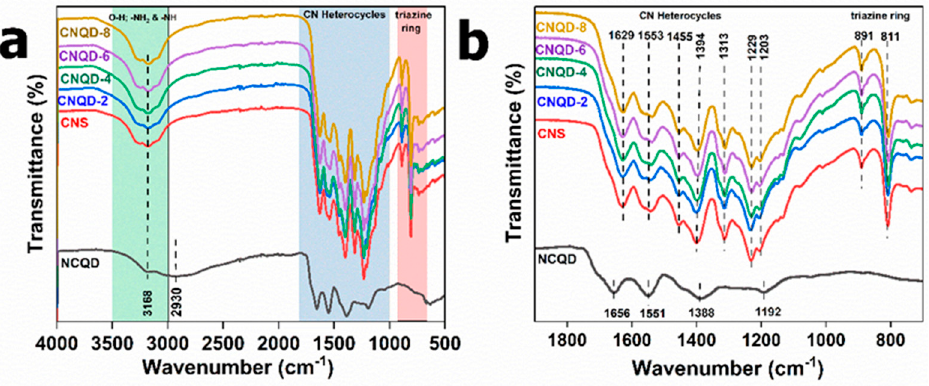
Figure 6. Full ( a ) and enlarged FTIR spectra ( b ) of NCQD, CNS, and CNQD photocatalysts.